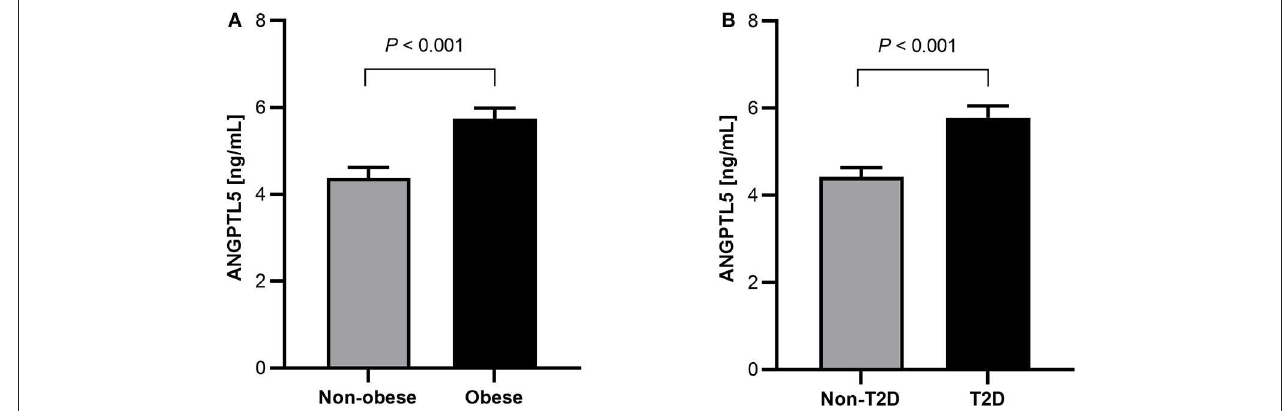
FIGURE 1 | (A) Circulation level of ANGPTL5 in non-obese ( n = 104) vs. obese subjects ( n = 100) as measured by ELISA. (B) Circulation level of ANGPTL5 in non-diabetics ( n = 109) vs. T2D subjects ( n = 95) as measured by ELISA. P < 0.05 was considered significant as determined using student’s t